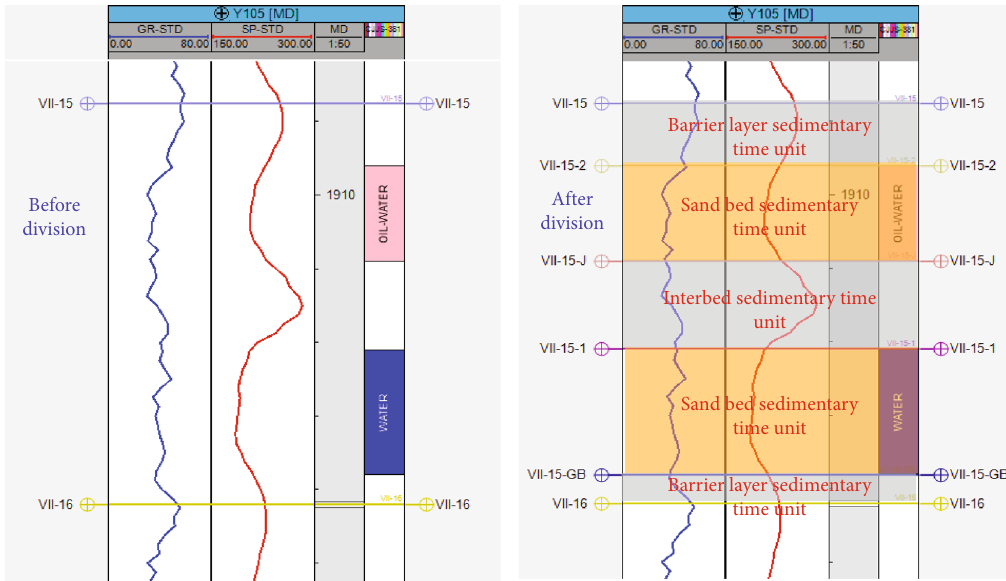
Figure 3: Division results of sedimentary time unit (Y105